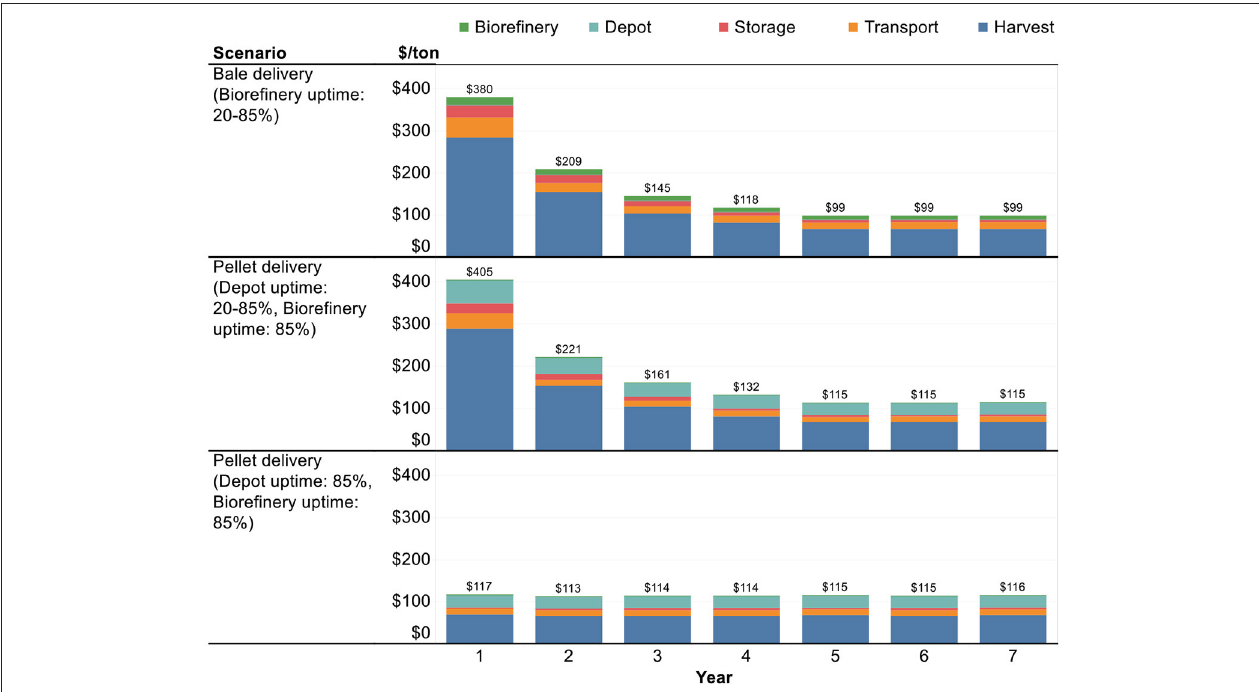
FIGURE 11 | Average delivered cost per ton corn stover processed ($/ton) for the bale-delivery (Biorefinery uptime: 20–85%), pellet-delivery (Depot uptime: 20–85%, Biorefinery uptime: 85%) and pellet-delivery (Depot uptime: 85%, Biorefinery uptime: 85%).